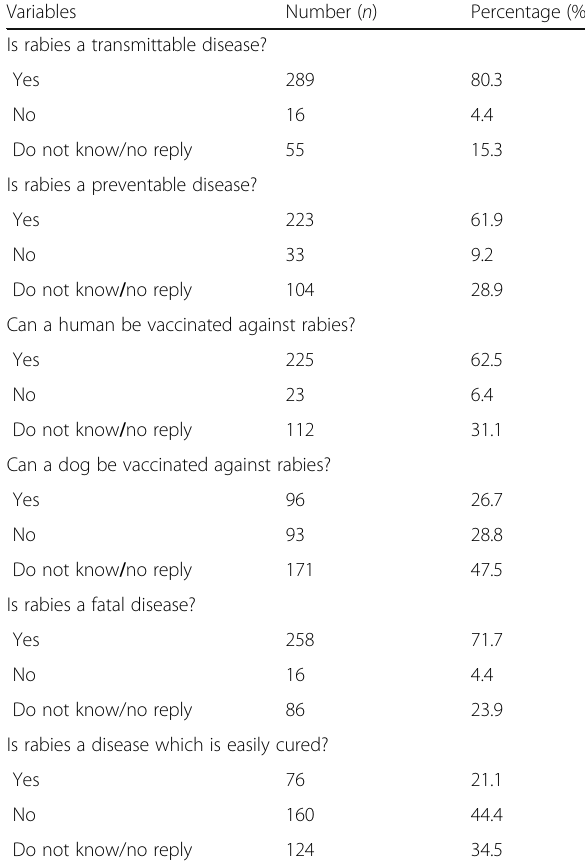
Table 3 Respondents ’ knowledge related to rabies ( n = 360)